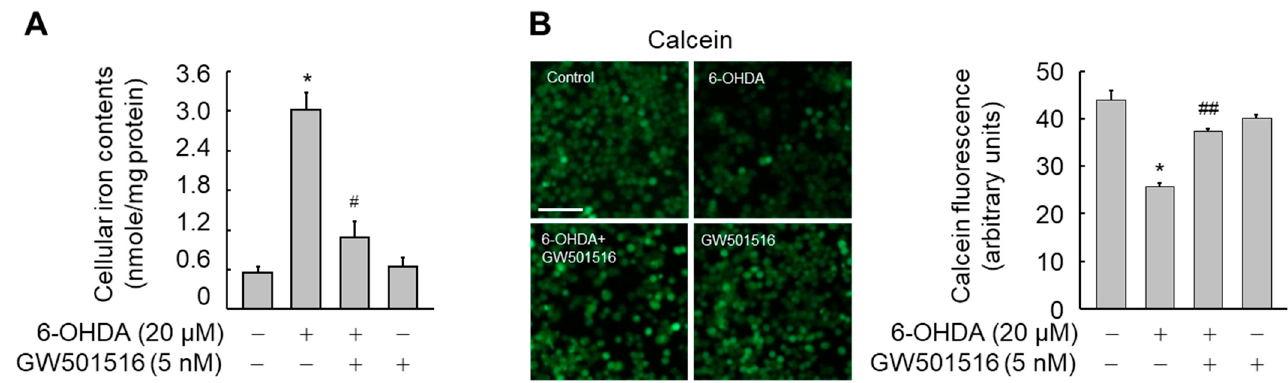
Figure 2. GW501516 activation of PPAR δ suppresses 6-OHDA-triggered accumulation of intracellular iron. Cells pretreated with vehicle (DMSO) or GW501516 for 8 h were incubated with or without 6-OHDA for 24 h. ( A ) Ferene-based colorimetric method was used to determine the intracellular iron levels. ( B ) Intracellular iron levels were also determined by measuring the reduced fluorescence of calcein-AM under fluorescence microscopy and then calcein fluorescence was quantitated using cells treated with DMSO as control. Results are expressed as means ± SE ( n = 3). Scale bar, 100 μ m. * p < 0.05 relative to untreated group; # p < 0.05, ## p < 0.01 relative to 6-OHDA-treated group.